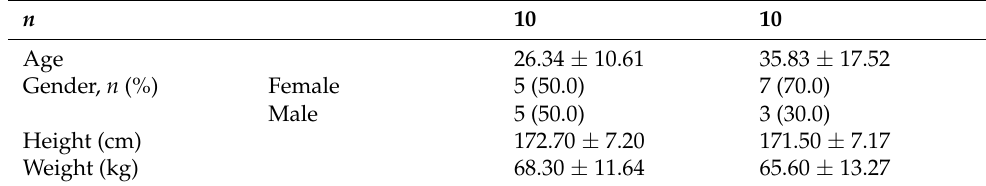
Table 1. Baseline characteristics of the